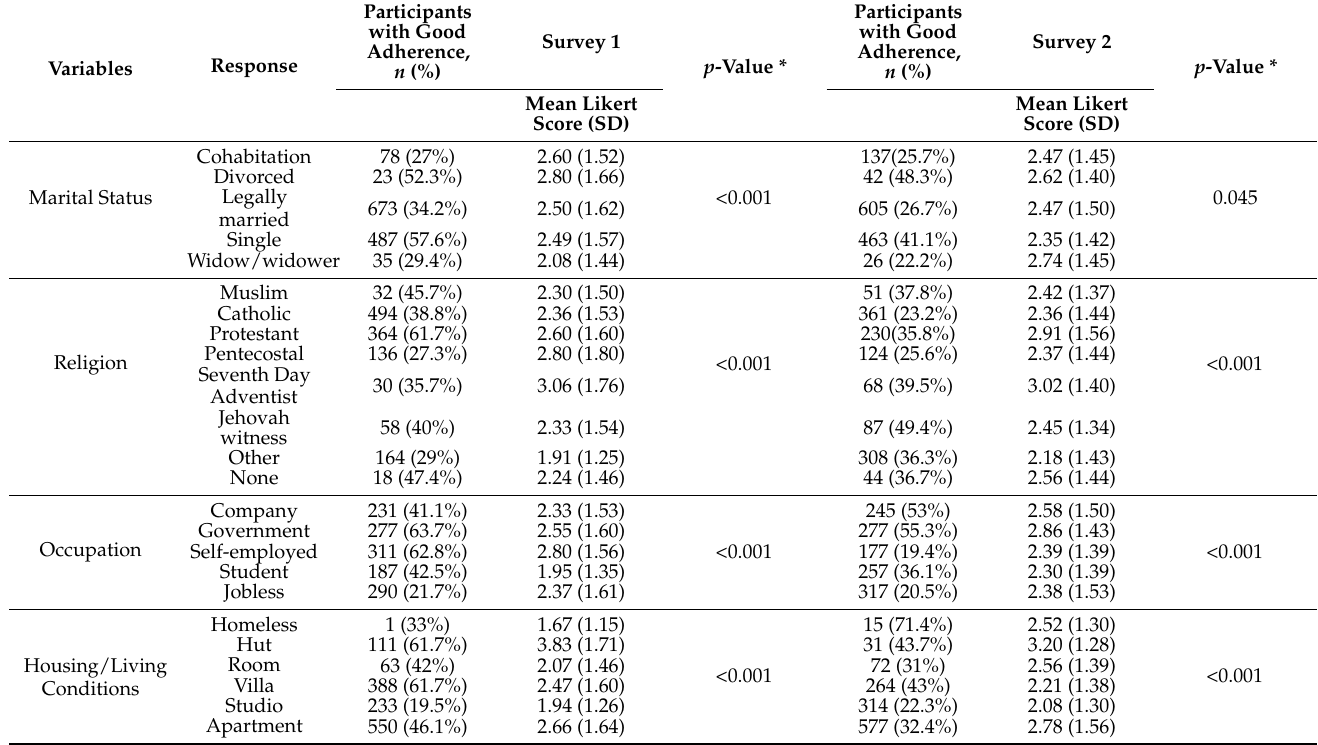
Table 4. Level of worry and fear concerning participant’s health in the midst of the COVID-19 pandemic (scored on a 5-point Likert scale).